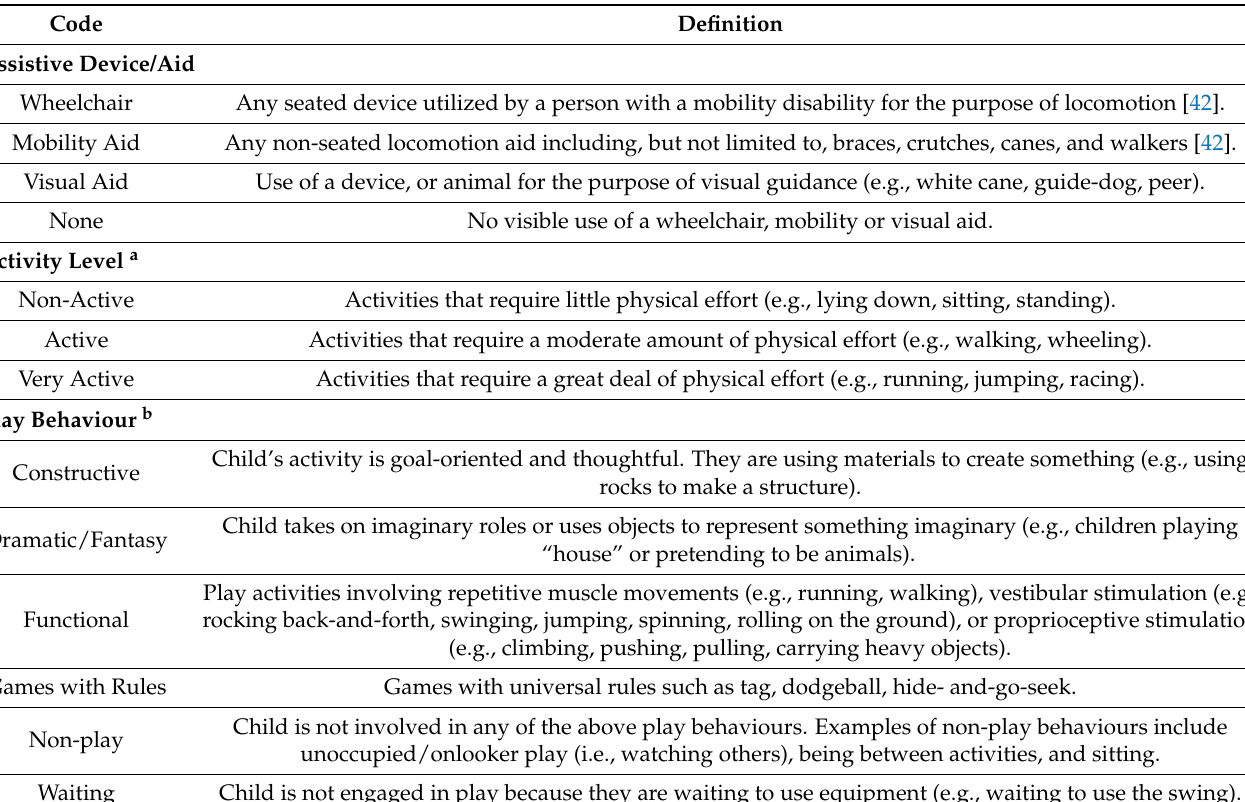
Table 1. Definitions of Codes Added to the Modified SOPARC